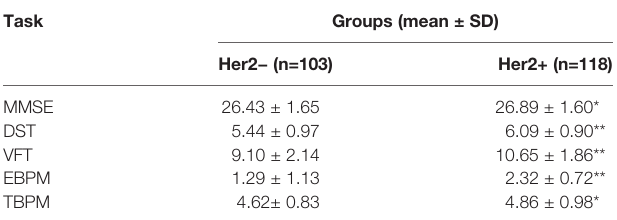
TABLE 3 | General assessment of cognitive in HER2 − and HER2+ groups after chemotherapy. Task